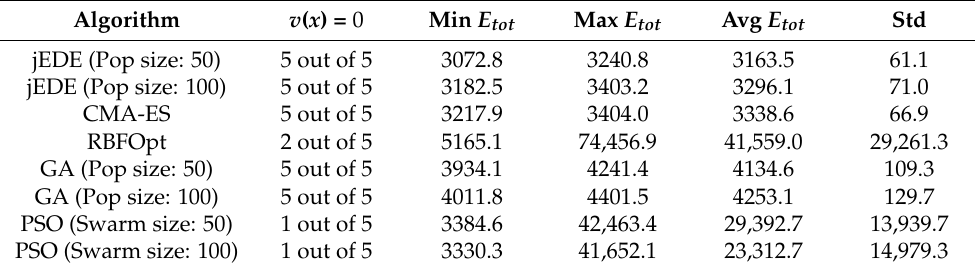
Figure 16. Boxplots of the feasible solutions. Table 8. Overview of the optimisation results for 5 replications at the building scale.